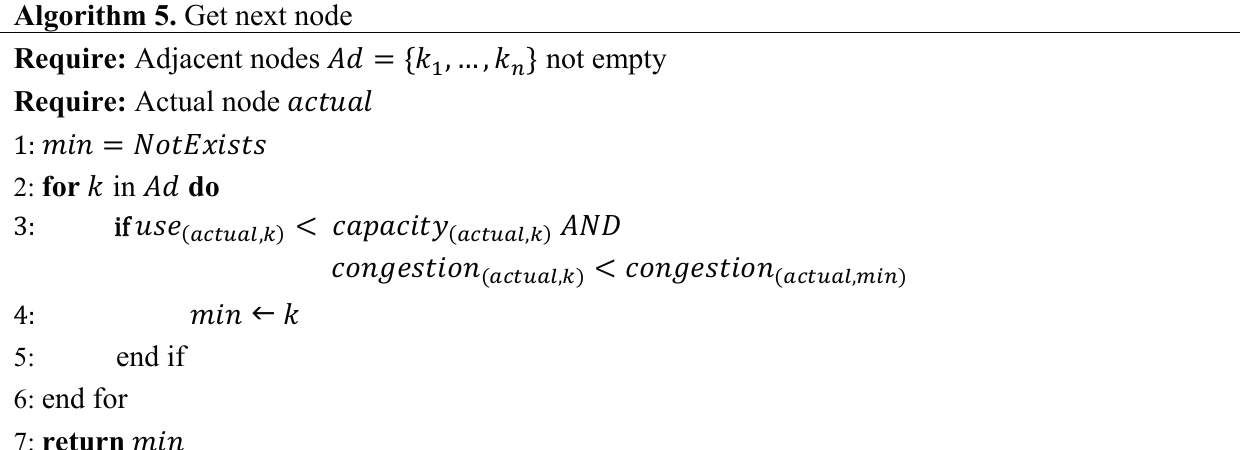
Algorithm 5. Get next